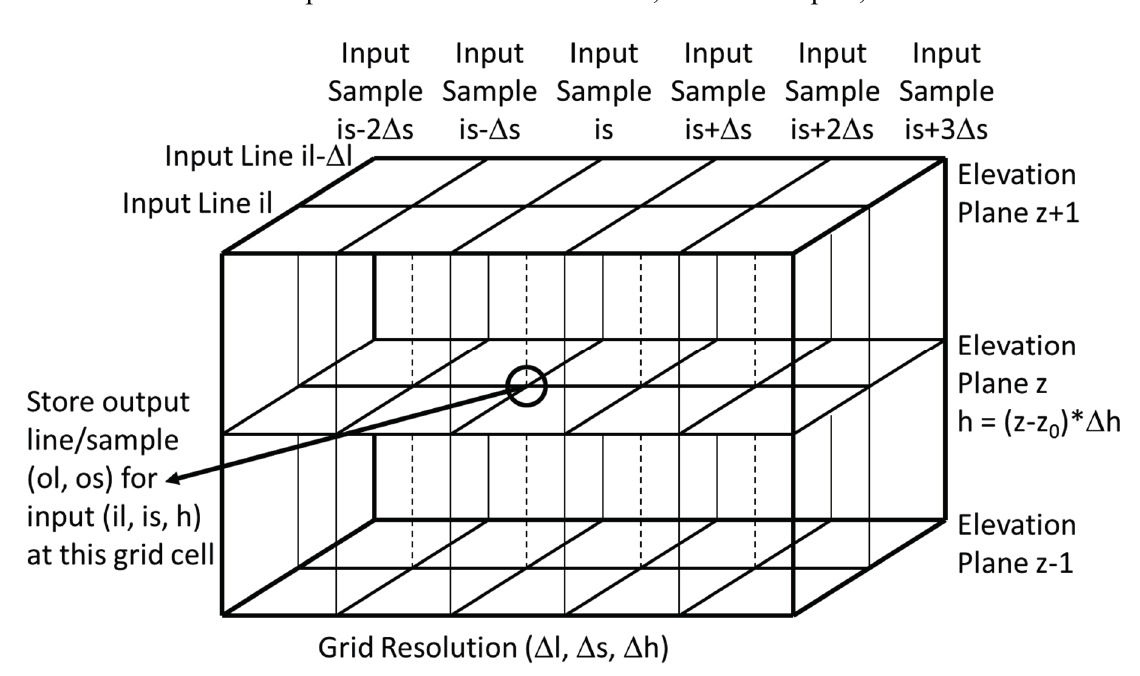
Figure 5. Three-dimensional grid of Level 1R line/sample/height coordinate to Level 1T line/sample mappings. The grid provides a convenient means to rapidly convert coordinates between the unresampled Level 1R image and the output Level 1T product. The nominal grid resolution for the multispectral bands is: Δ l = 30 lines, Δ s = 40 samples, and Δ h = 500